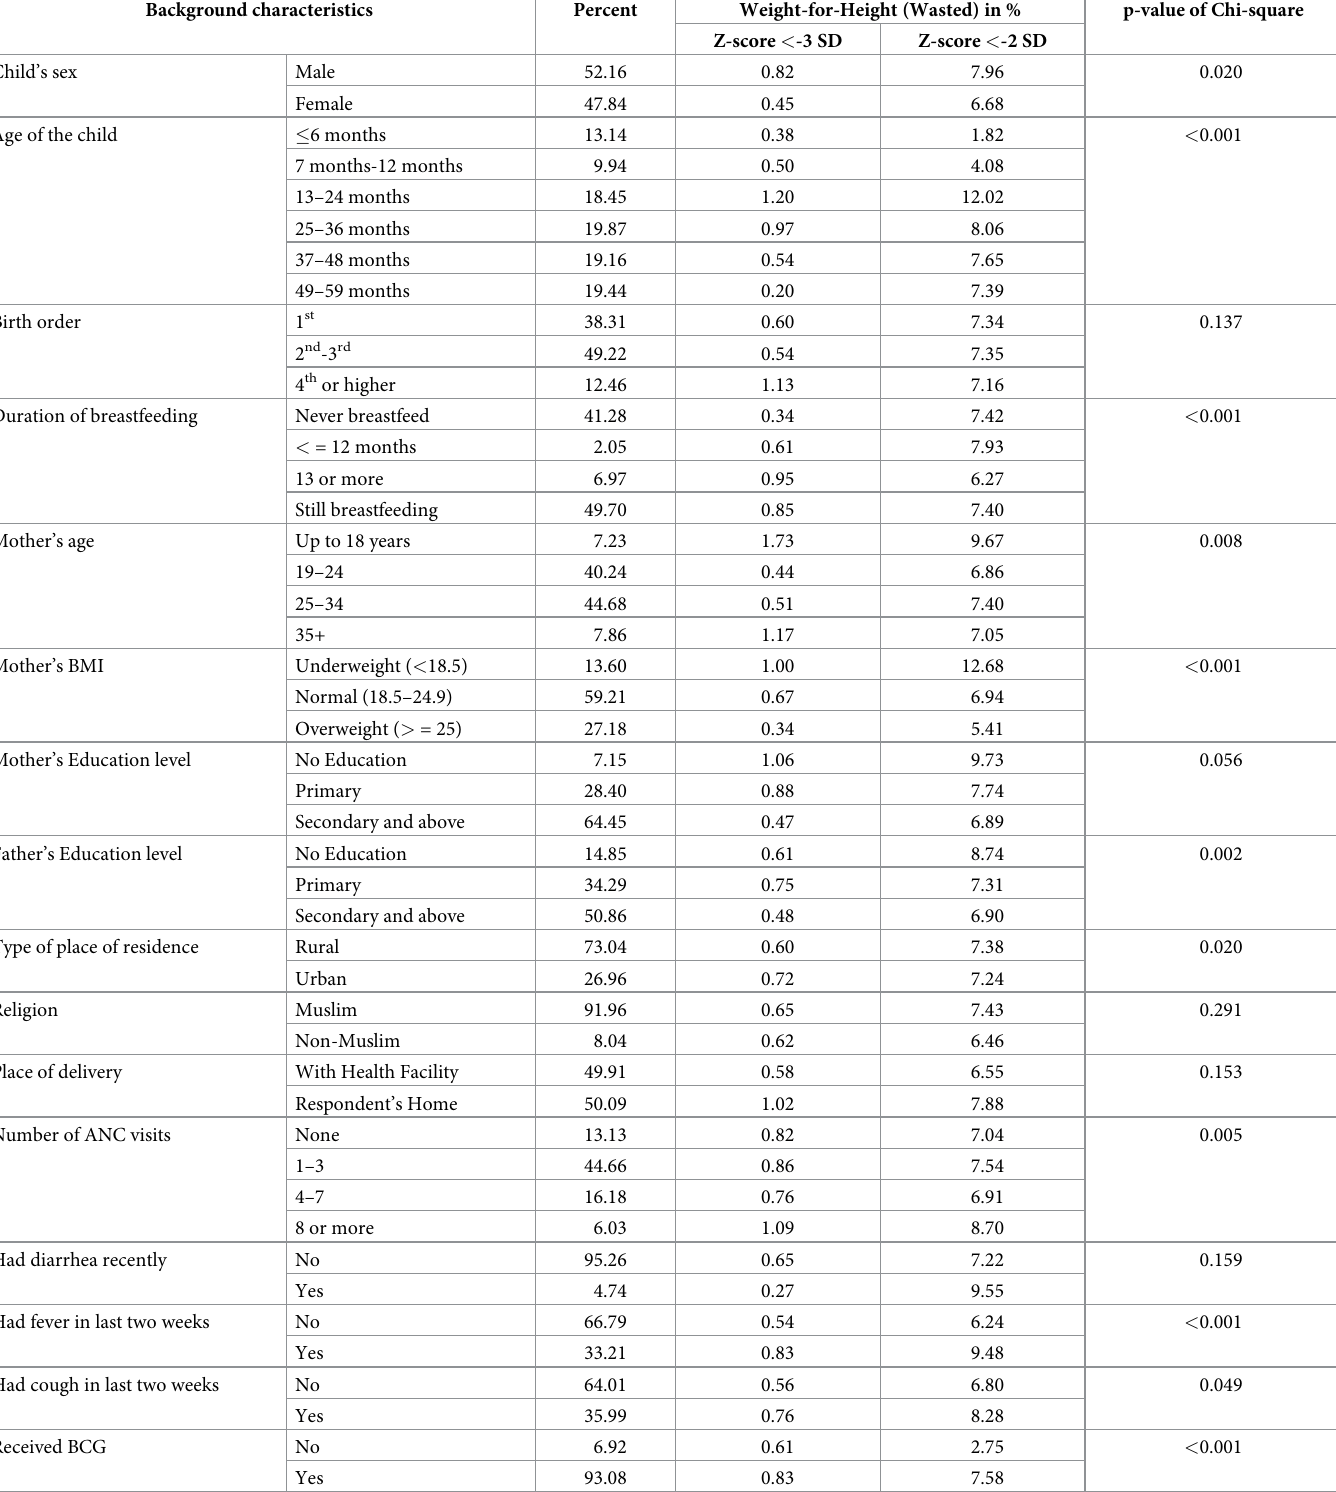
Table 1. Percent distribution of child malnutrition according to wasting by background characteristics. Background